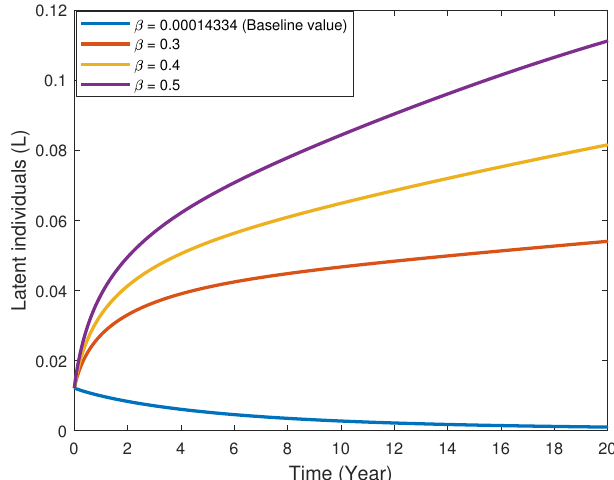
Figure 10. Behavior of L class for different β values.